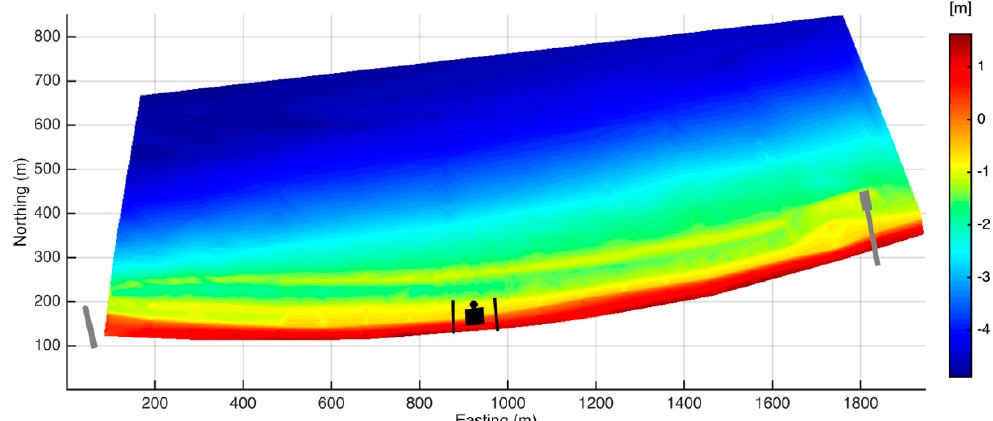
Figure 3. Bathymetry measured two days before the experiment (25 May 2015), showing the study area ( █ ), the ADV ( • ) and the updrift/downdrift control lines (black solid lines) locations. The study site is located between the jetty of the Sisal port entrance channel (left-hand side, gray line) and the Sisal pier (right-hand side gray feature). The color bar indicates the elevation with respect to the mean sea level.